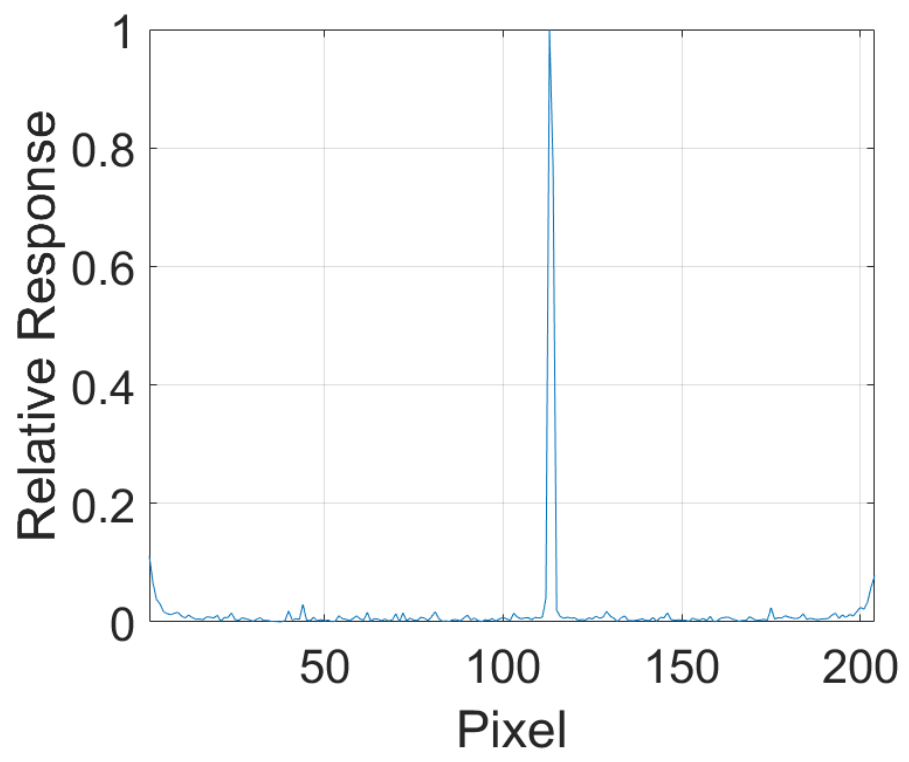
Figure 4. Response of the 150 th column on the HARIS image plane at 770.05 nm. After the acquisition of the wavelength calibration data, the response of each pixel to different wavelength light signals were fitted with the Gaussian curve, and the slit func- tion of each pixel on the image plane was obtained. Figure 5 shows the slit function of the 150th pixel in the 120th row. The central wavelengths that correspond to the pixels in the 150th column are presented in Figure 6, which depicts a nonlinear distribution of wave- lengths on the image plane.